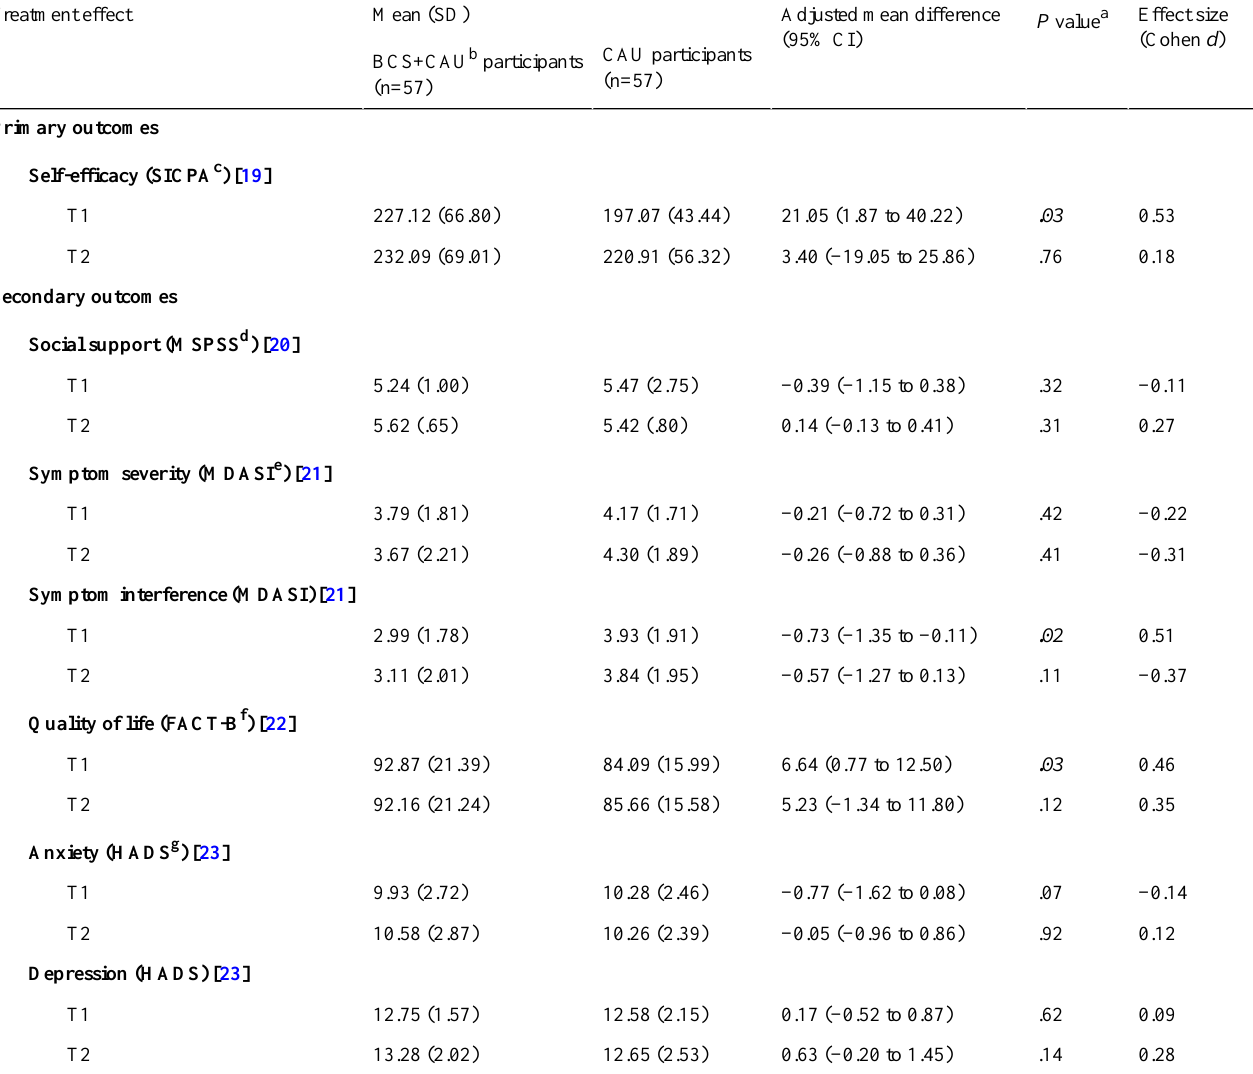
Table 2. Effect of breast cancer e-support (BCS) program (intention-to-treat analysis) on primary and secondary outcomes at 3 months (T1) and 6 months (T2);